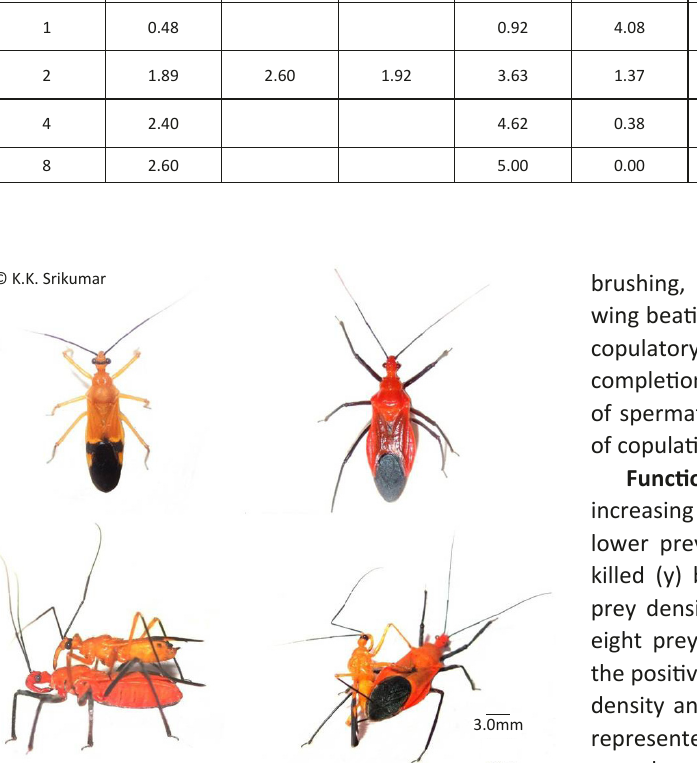
Table 4. Functional response of C. gilvus towards H. antonii Prey density (x)